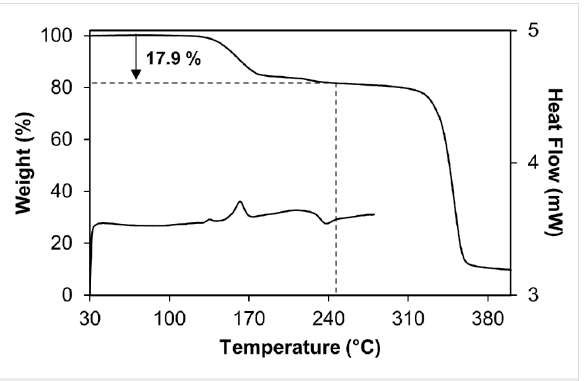
Figure 2: Representative TGA (top) and DSC (bottom) traces for DIMEB· 1